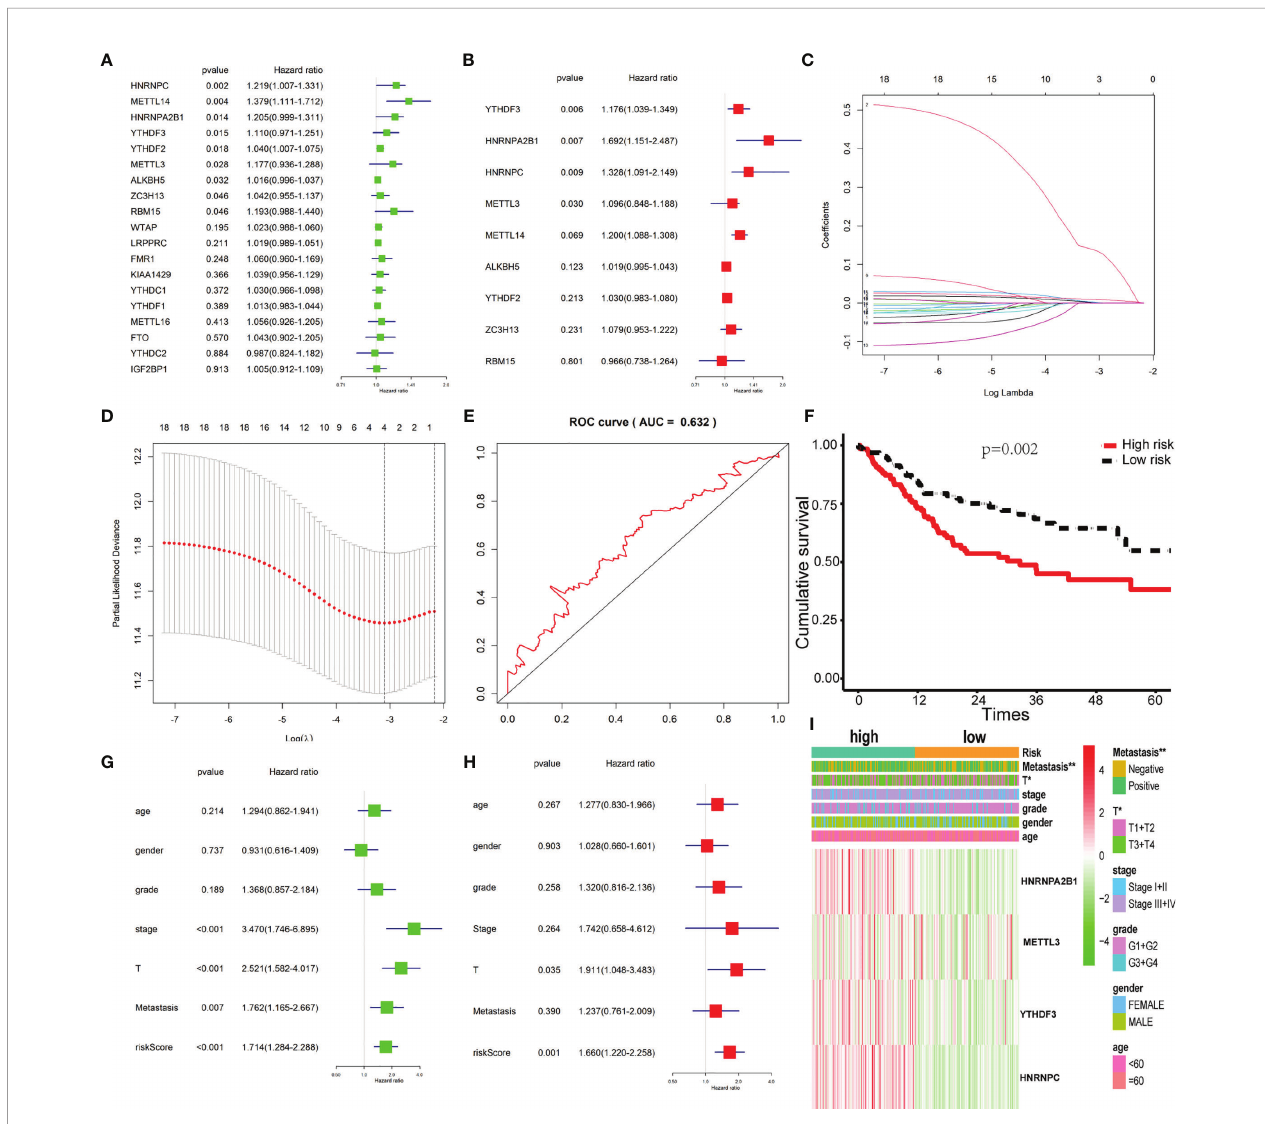
FIGURE 3 | Construction of the Cox regression model and validation of the prognostic signature. (A, B) Univariate and multivariate cox regression based on 19 m 6 A-related genes. (C) LASSO coef fi cient pro fi les of 19 m 6 A-related genes associated with the overall survival of OSCC; each curve represents a gene. (D) Partial likelihood deviance is shown against log (lambda). The vertical dotted line indicated the lambda value with the minimum error and the largest lambda value, where the deviance is within one SE of the minimum. (E) The prognostic signature model showed good prediction ef fi ciency with the area under the ROC curve (AUC = 0.632). (F) Survival analysis based on risk score. (G, H) Univariate cox regression and multivariate cox regression according to risk score and clinical characteristics. (I) The heatmap of risk score level and clinical characteristics. * and ** indicated p<0.05 and p<0.01,